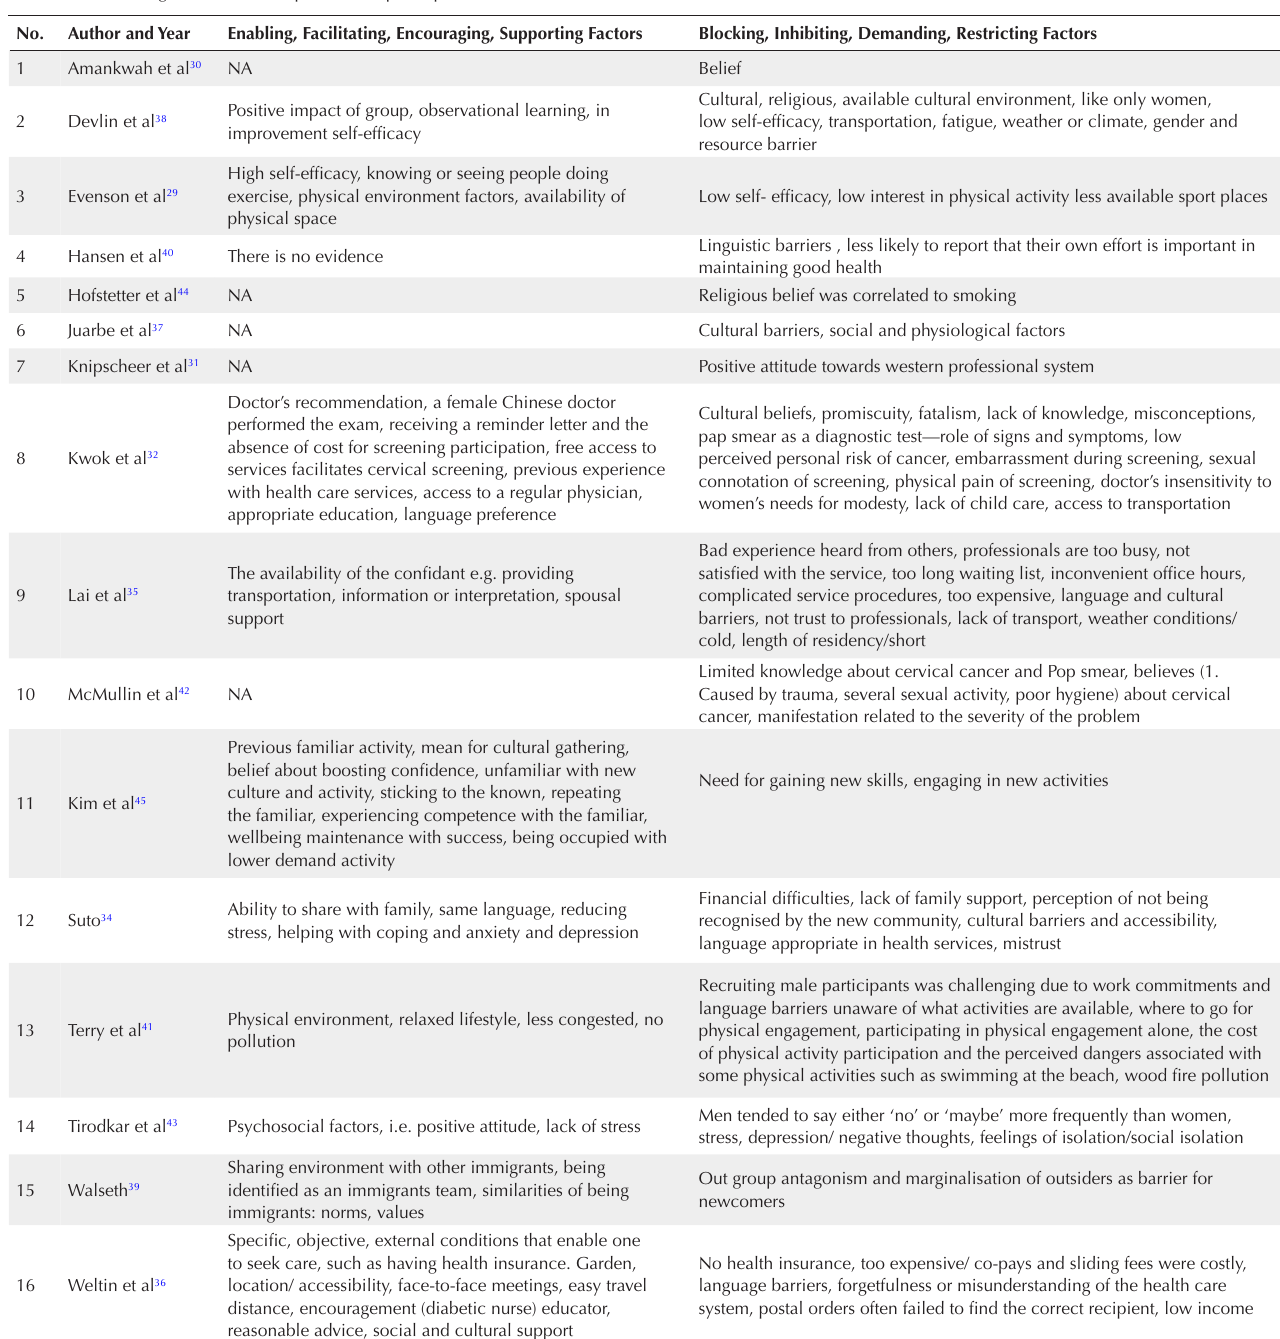
Table 4. Contributing Factors to Participation/Non-participation in Various Studies No. Author and